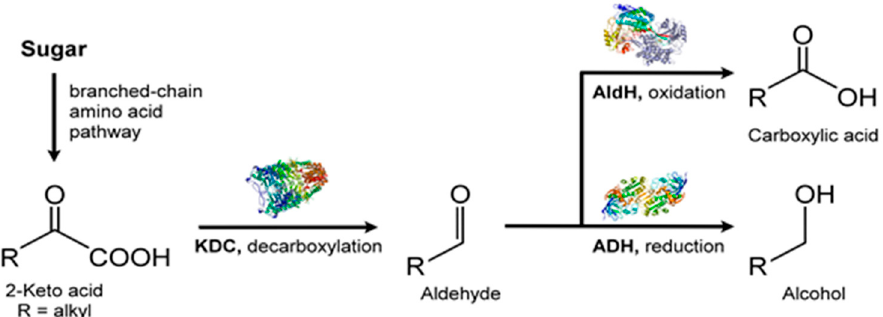
Figure 12. 2-Ketoacid pathway for the production of alcohols and acids. KDC, 2-ketoacid decarboxylase; ADH, alcohol dehydrogenase; AldH, aldehyde dehydrogenase.